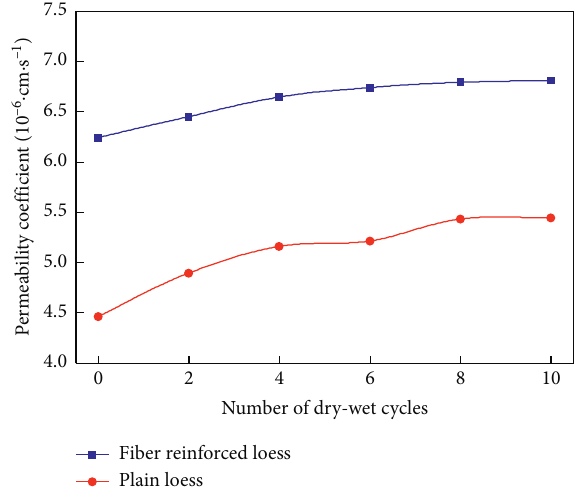
Figure 4: The effects of D-W cycles on permeability with the number of